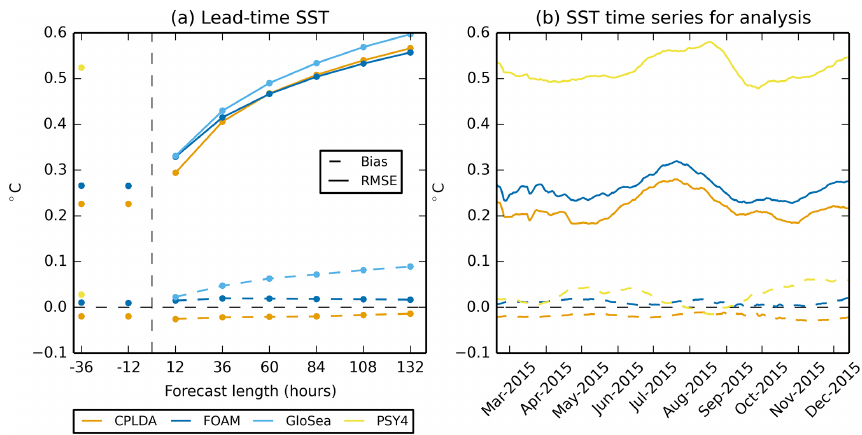
Figure 5. SST (model minus observation) class 4 statistics with respect to drifting buoys: (a) RMSE and mean biases at various lead times; (b) time series of RMSE and mean biases in the “best analysis” from each system.